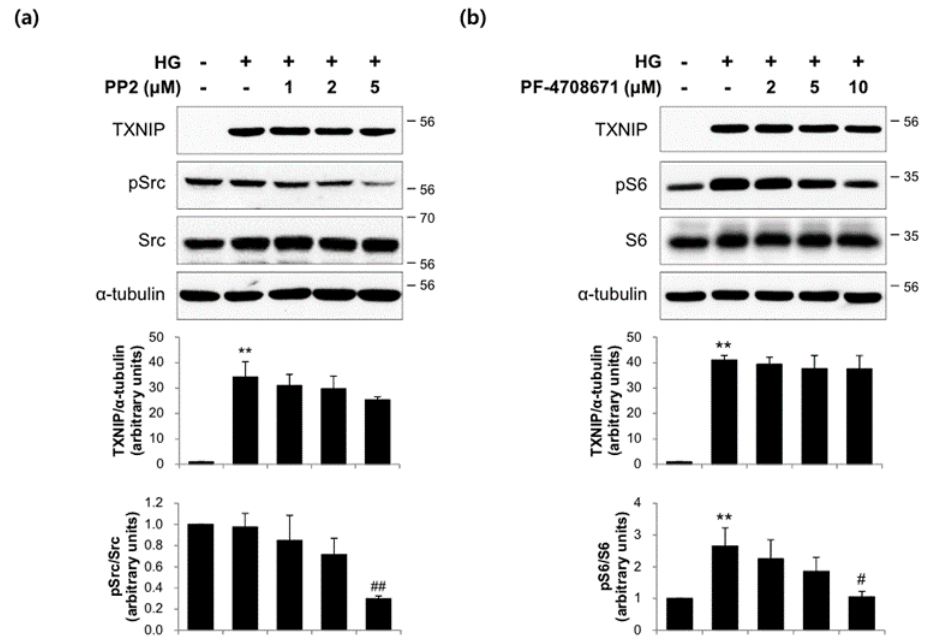
Figure 4. Src and S6K1 kinases were not involved on HG-induced TXNIP expression. ( a ) INS-1 cells were pretreated with PP2 (1, 2 or 5 µ M; an inhibitor of Src) for 1 h, and then incubated in high glucose (HG, 25 mM) for 24 h. Protein levels were measured by immunoblotting. The graph shows the densitometric quantification of western blot bands. Results are expressed as means ± SDs and are representative of three independent experiments. * p < 0.05 vs. non-treated controls, # p < 0.05 vs. HG-treated cells ( b ) INS-1 cells were pretreated with PF-4708671 (2, 5 or 10 µ M; an inhibitor of S6K1) for 1 h, and then incubated with HG for 24 h. Protein levels were measured by immunoblotting. The graph shows the densitometric quantification of western blot bands. Results are expressed as means ± SDs and are representative of three independent experiments. * p < 0.05 and ** p < 0.01 vs. non-treated controls, # p < 0.05 vs. HG-treated cells.